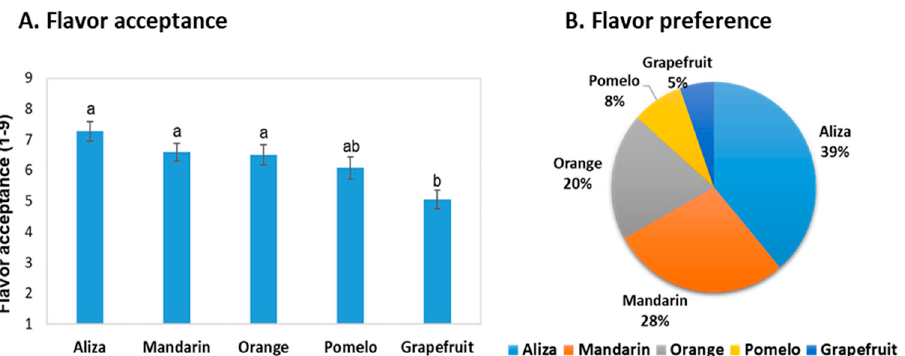
Figure 5. Consumer ( A ) flavor acceptance and ( B ) flavor preference scores for ‘Aliza’, grapefruit, pomelo, orange and mandarin. Data are means ± S.E. of the scores assigned by 90 testers. Different letters in A indicate significant differences at p ≤ 0.05.